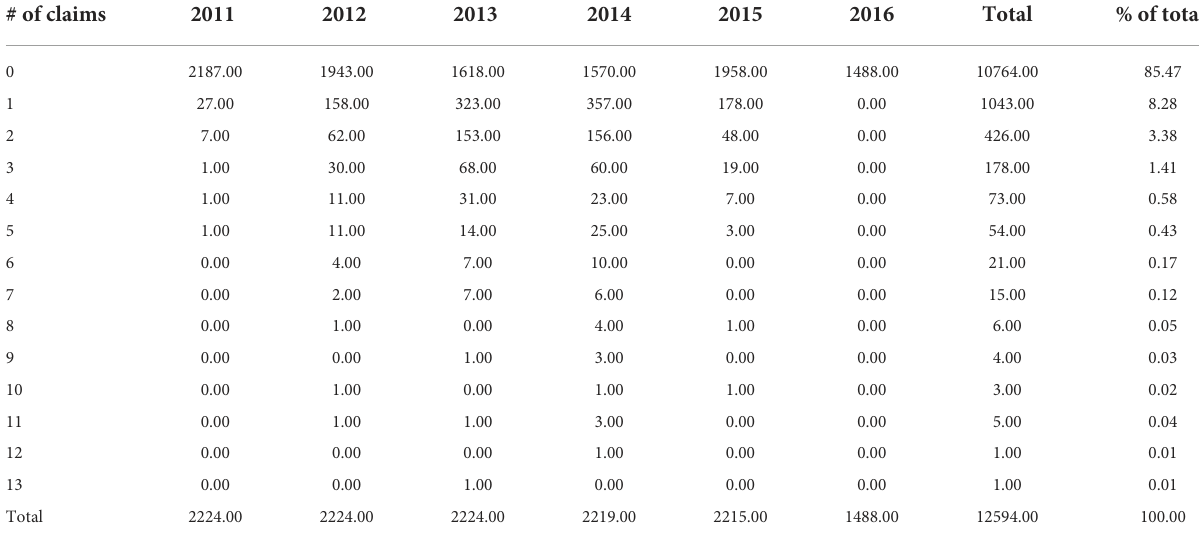
TABLE 1 Number and percentage of claims, by count and year for the 2011 cohort.